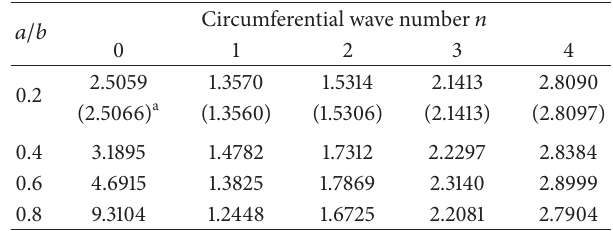
Table 8: Frequency parameters, Ω = 𝜔𝑏(𝜌(1− V 2 )/𝐸) 1/2 , for SS1-SS1 annular plates with different cutout ratios.